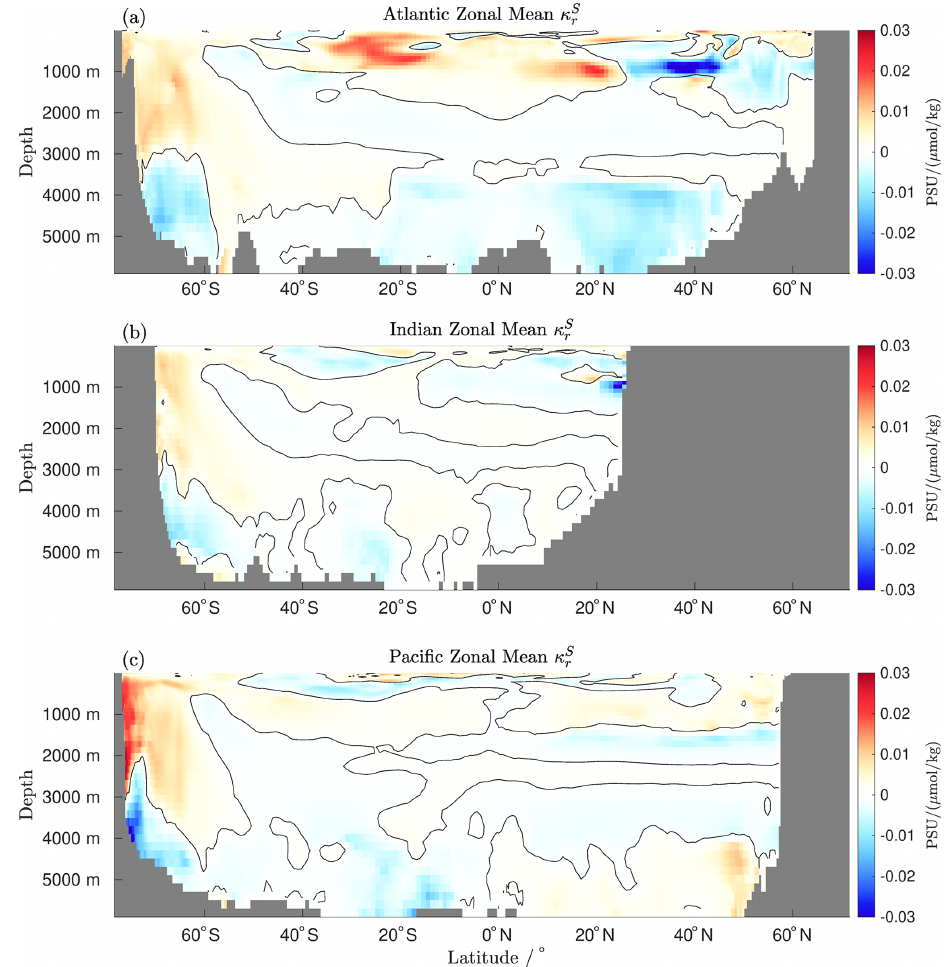
Figure D2. Zonal mean effective κ S r values for the Atlantic (a) , the Indian Ocean (b) , and the Pacific (c) .